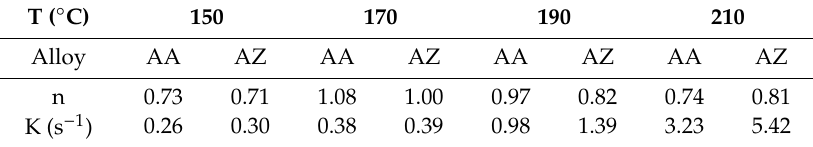
Table 8. Values of n and K for alloy AA and AZ at di ff erent aging temperatures